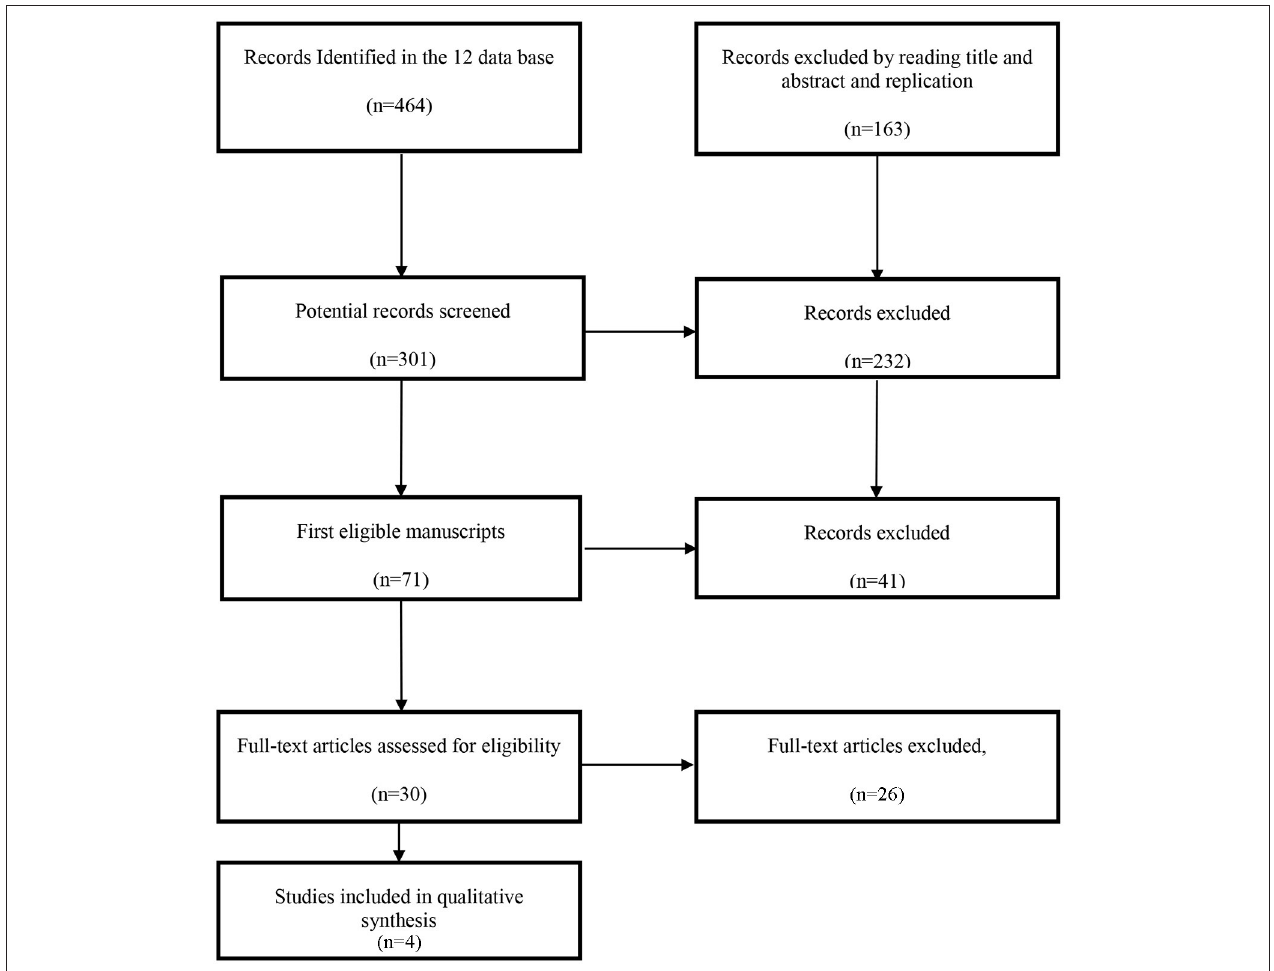
FIGURE 1 | Flowchart of studies included following PRISMA guidelines.